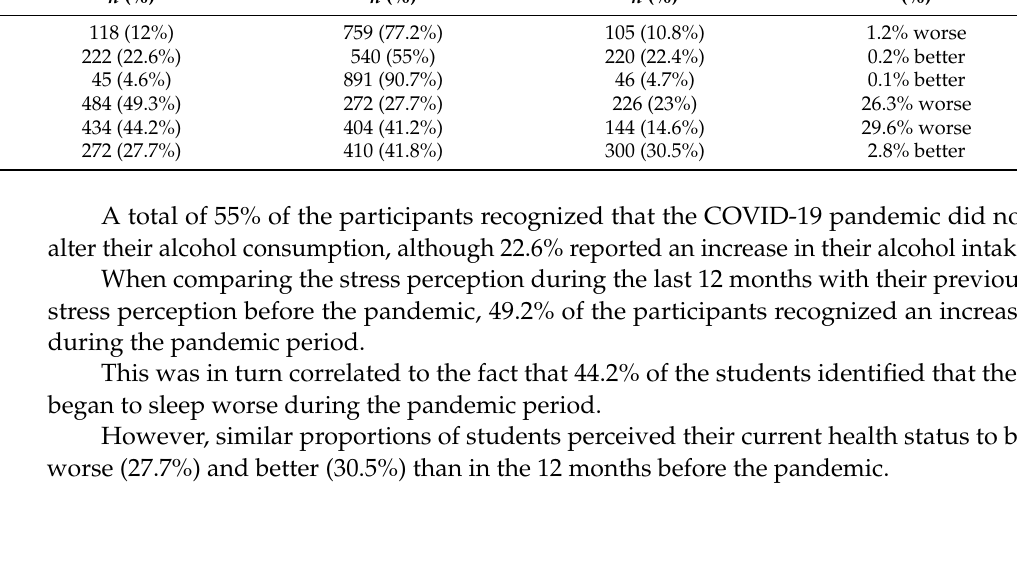
Table 6. Students’ perception of the influence of the COVID-19 pandemic on their lifestyles ( n = 982). Increased Habit/Worsening n